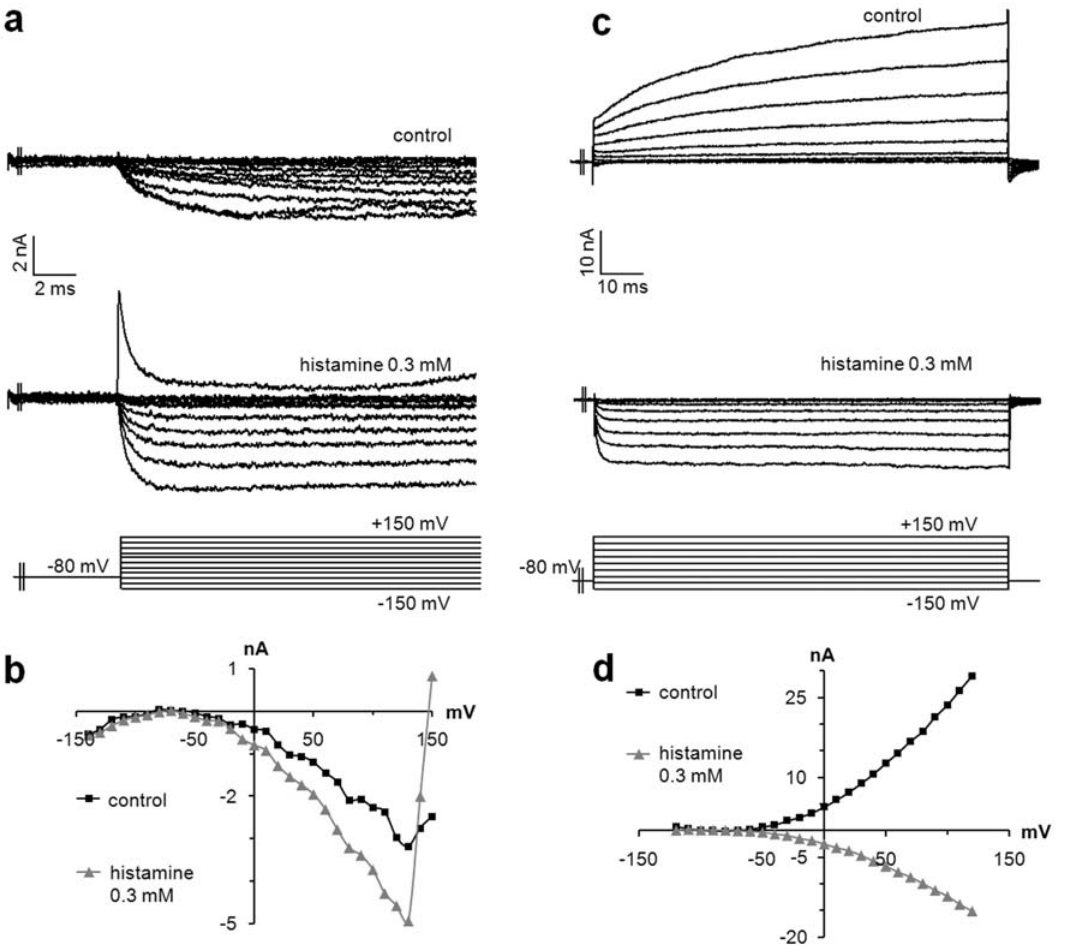
Figure 7. Histamine induces inward currents in MCs. The histamine H3 receptor was identified at the surface of MCs. Its activation induced inward Ca 2 + currents in MCs. Representative current densities recorded during a series of depolarizing steps in control conditions (a, c: top traces). Inward slow activating Ca 2 + currents (a) or outward fast activating K + currents (b) were identified as revealed by the current-voltage relationships (b, d: black squares). In both conditions, the addition of histamine (300 m M) induced inward Ca 2 + currents without inactivating components (a, c: bottom traces) as demonstrated by the current-voltage relationships (b, d: grey triangles).